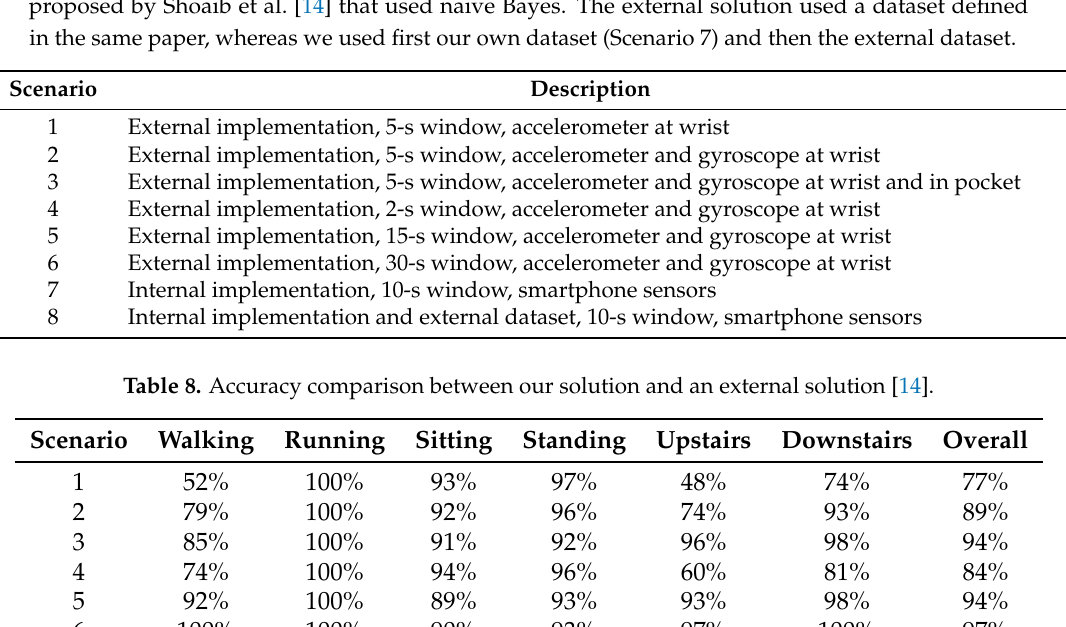
Table 7. Scenarios for activity recognition solutions’ comparison. The internal implementation refers to